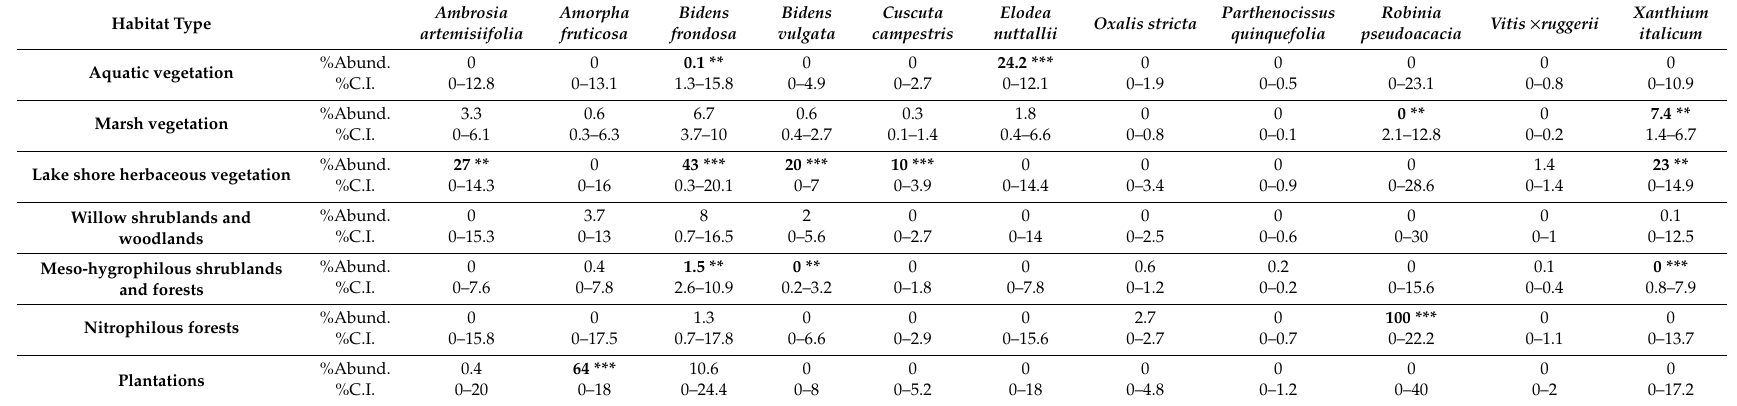
Table 3. For each habitat type, the observed mean abundance (expressed as % cover of the plot) of the IAS are shown with the 95% confidence intervals (C.I.) obtained from 9999 Monte Carlo simulations. In bold and with asterisks, the IAS mean abundance is significantly di ff erent than expected (*** p < 0.001; ** p < 0.01; * p <